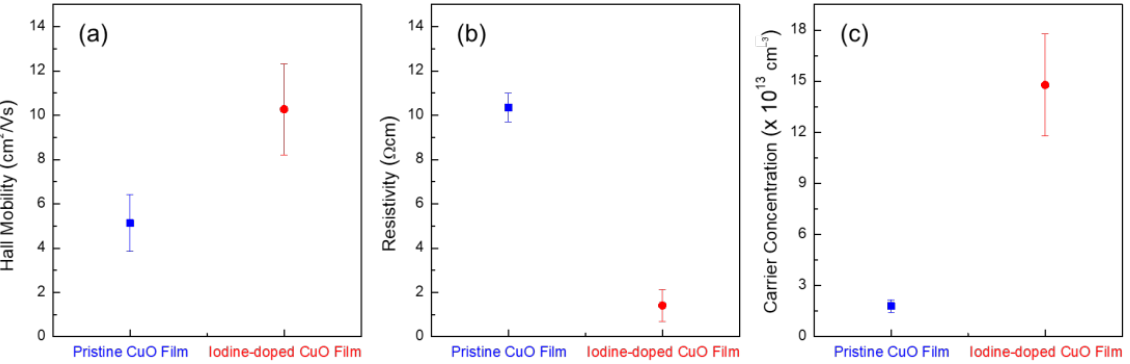
Figure 6. Hall effect measurements of pristine and iodine-doped CuO films. ( a ) Hall mobilities, ( b ) resistivities, and ( c ) hole-carrier concentrations.